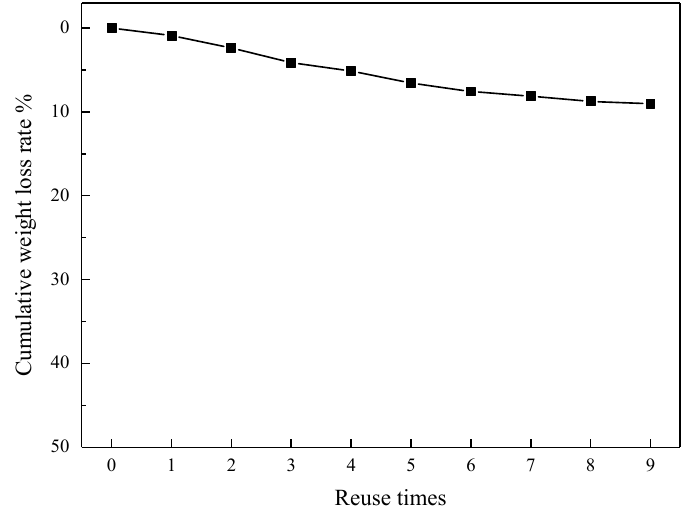
Figure 12. Relationship between coke powder adsorbent reuses times and the cumulative weight loss rate.